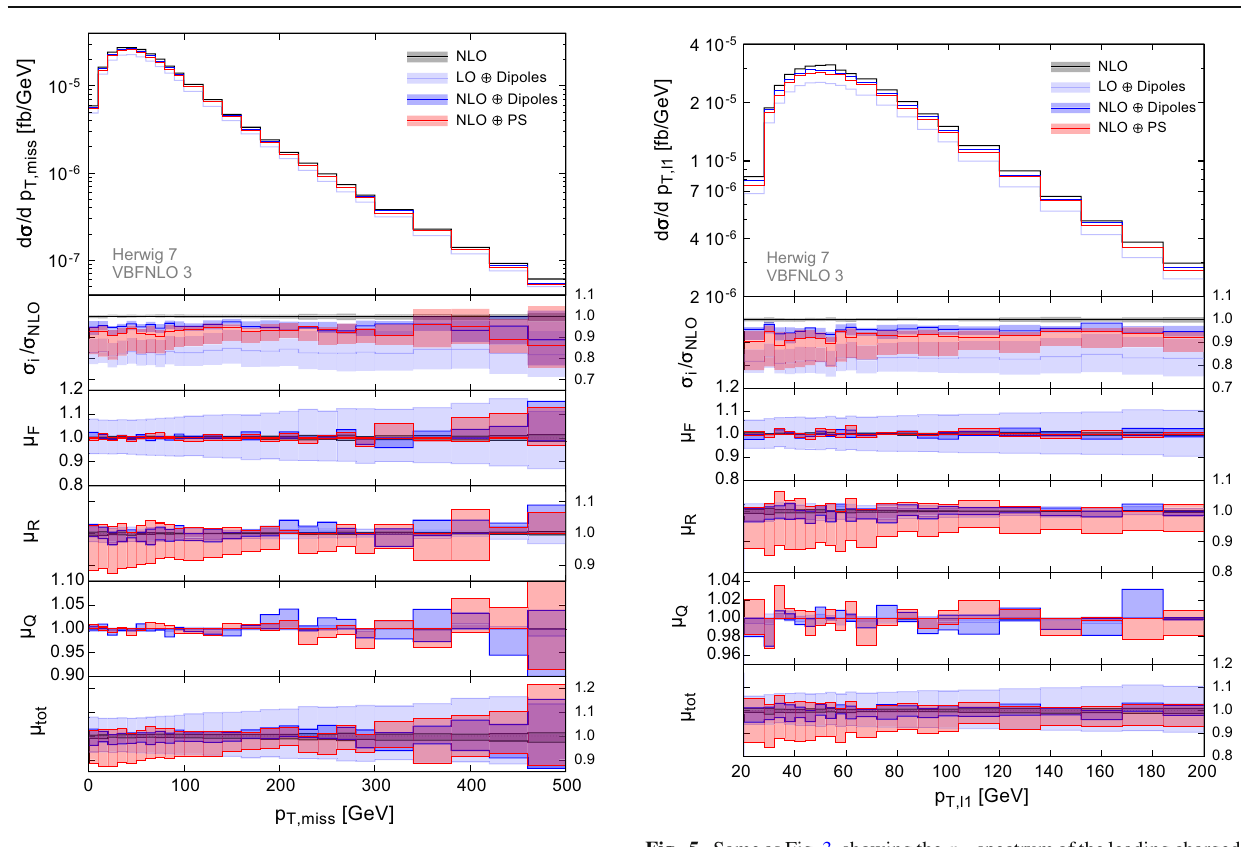
Fig. 4 The cross section predictions differential in the missing trans- verse momentum. See Fig. 3 and the text for more discussion the angular-ordered shower when lowering the renormaliza- tion scale appearing as argument of the strong coupling; this effect is only visible at the level of the hard tagging jets and we therefore conclude that it is originating from an increased cut migration due to enhanced radiation present in this vari- ation.